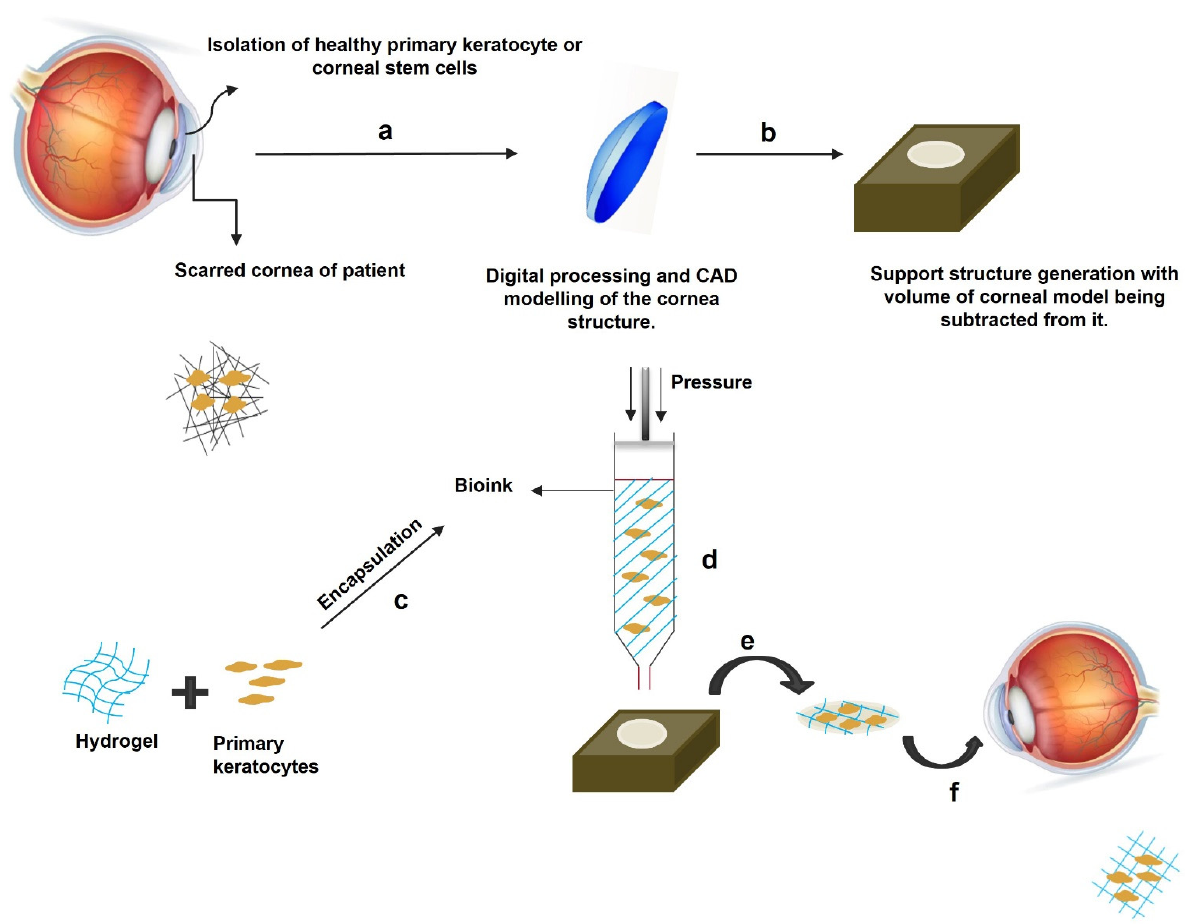
Figure 9. The 3D bioprinting of corneal stroma. The patient with corneal scarring has a disorganized opaque corneal ECM that must be replaced with a 3D-bioprinted corneal stromal layer. The isolation of corneal stromal stem cells or healthy keratocytes from the patient cornea; ( a ) digital image processing of the patient’s cornea to obtain its 3D model, with dimensions that are identical to those of the patient’s cornea; ( b ) generation of a support structure and subsequent substructions of the corneal model volume to obtain a hollow surface mimicking the patient’s corneal structure, onto which 3D bioprinting is carried out; ( c ) preparation of collagen/alginate/gelatin/dECM hydrogel and culturing of either corneal stromal cells or primary keratocytes in appropriate culture media, followed by encapsulation of corneal cells into the hydrogel to prepare the bio-ink; ( d ) loading the bio-ink into the extrusion 3D bioprinter. ( e ) bioprinting the corneal stromal construct. ( f )